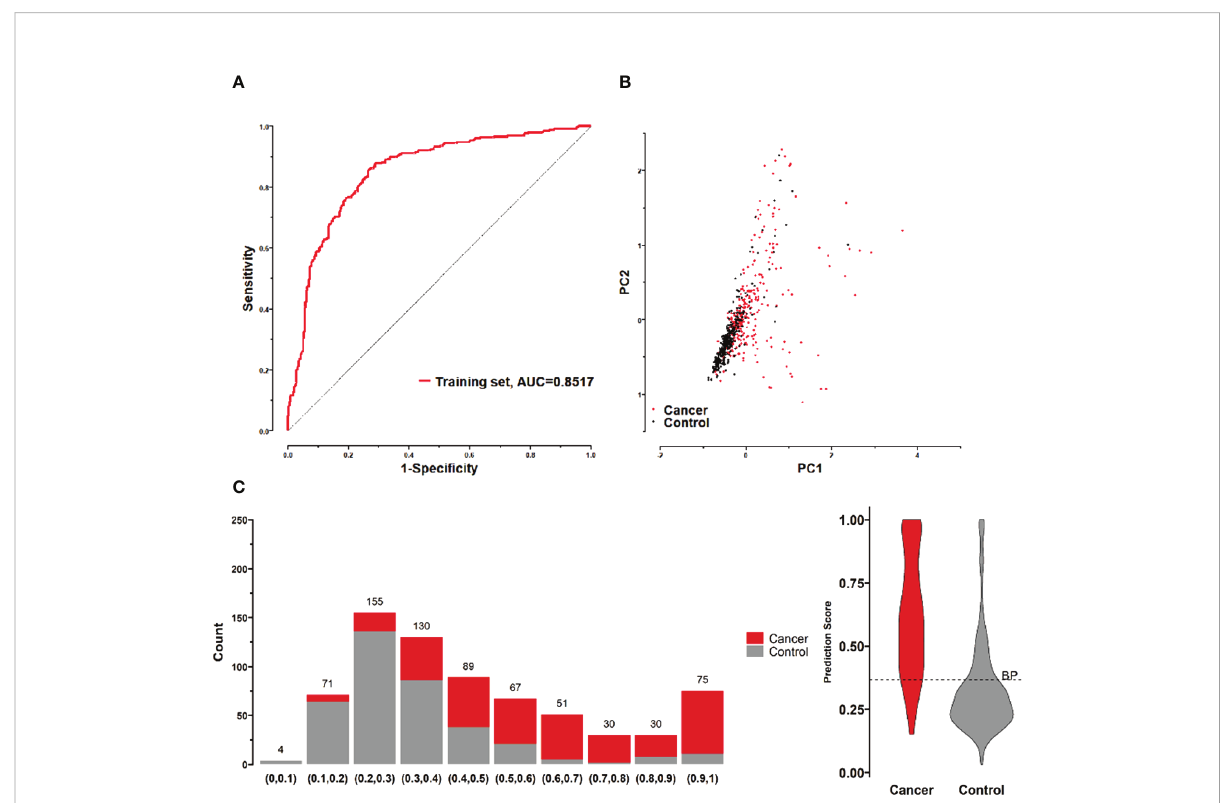
FIGURE 7 (A) ROC curves of 8 lung cancer antigens (ZNF573, BRAF, TM4SF1, SOX2, MAGE.A4, BMI1, FXR1, and HuC) in the training set; (B) Principal component analysis of 8 lung cancer antigens (ZNF573, BRAF, TM4SF1, SOX2, MAGE.A4, BMI1, FXR1, and HuC) in the training set samples, and scatter plots using principal component 1 and principal component 2 as coordinates for samples in control and tumor groups. (C) Distribution of the prediction scores for the logistic regression model fi tted to 8 lung cancer antigens in the training